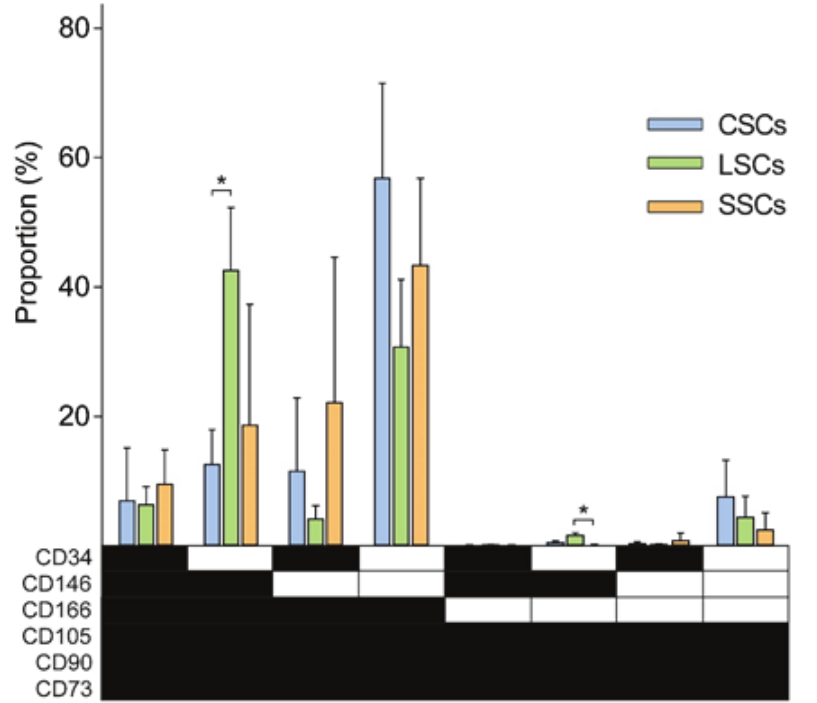
Figure 3. Distribution of phenotypical variants based on co-expression of six selected CD markers in stromal cells cultured from three distinct ocular surface compartments. The data are presented as Means ± SD and asterisks indicate statistical significance at p < 0.05. N = 4 for CSCs and SSCs, and n = 3 for LSCs. (cid:4) The marker is expressed. (cid:3) The marker is not expressed. CSCs, corneal stromal cells; LSCs, limbal stromal cells; SSCs, scleral stromal